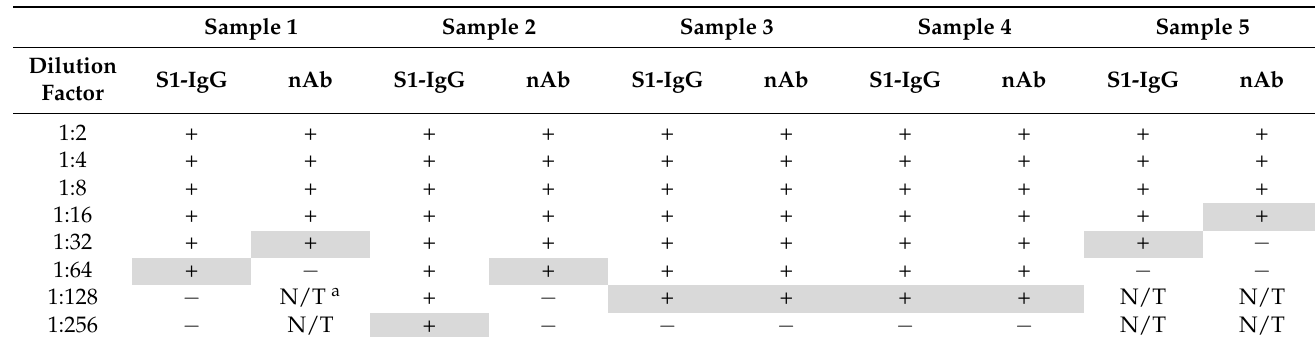
Table 3. Evaluation of the limit of detection of the RapiSure COVID-19 S1 IgG/Neutralizing Ab Test using positive samples with a PRNT 90 titer of 1:160. The gray-shaded boxes indicated their lowest dilution factor.